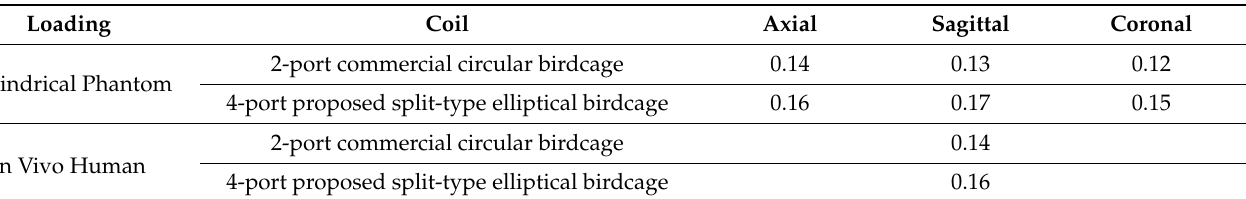
Table 4. Pre-calibrated RF pulse power in cylindrical uniform phantom and in vivo human (min–0/max–1) for commercial circular birdcage and proposed split-type elliptical